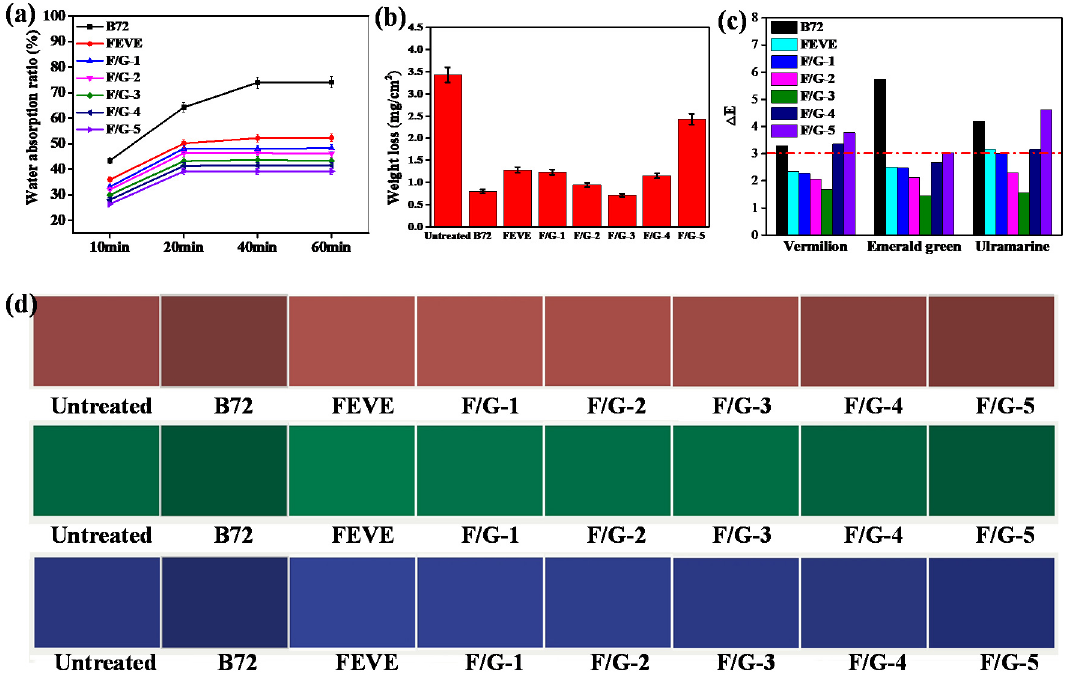
Figure 6. ( a ) Capillary water uptake ratio of the simulated samples treated by B72, FEVE, F / G- X ( X = 1–5). ( b ) Weight loss of the simulated samples consolidated with the B72, FEVE, F / G- X ( X = 1–5) coatings in the STT. ( c ) CIELAB ∆ E changes of vermilion, ultramarine, and emerald green pigments after consolidation treatment. ( d ) Color change pictures of simulated samples treated with B72,